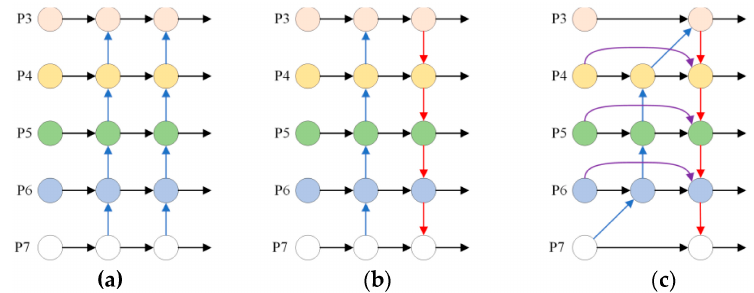
7 of 15 Figure 4. Comparison of backbone network improvements. ( a ) YOLOv5 backbone network struc- ture. ( b ) YOLO-GBC backbone network structure. 3.3. C-FPN Network YOLOv3 adopts unidirectional fusion network FPN for feature fusion, and its struc- ture is shown in Figure 5a. This structure is easy to lose the underlying target information in the process of transmitting high-level semantic features in a multi-layer network. YOLOv5 adopts a bidirectional network combining FPN and PAN for feature fusion, and its structure is shown in Figure 5b. FPN conveys strong semantic features from the high level to the low level, and PAN conveys strong positioning features from the low level to the high level. The two combine to aggregate different features, effectively enhancing the feature fusion capability of the network. However, from the structure of PAN and FPN, each input of PAN is the feature information processed by FPN, in which is easy to lose the original feature information in feature fusion, affecting the detection effect. Addition- ally, the FPN architecture employs the nearest-neighbor method for sampling, which only determines the sampling center based on the spatial location between pixels and cannot capture the rich semantic information required for intensive prediction tasks. To solve the problem of insufficient feature fusion and easy loss of target information in Figure 5a,b, the BIFPN structure is proposed for feature fusion. The structure is shown in Figure 5c. BIFPN constructs a two-way channel from top to bottom and from bottom to top. For